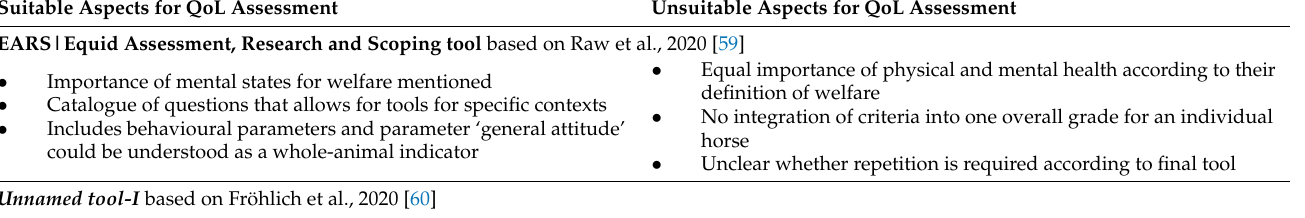
Table 5. Suitable and unsuitable aspects of the different assessment tools for assessing QoL according to our working definition based on the tool’s definition of welfare or QoL, parameters used, the integration of parameters into an overall grade and assessment of long-term vs. short-term